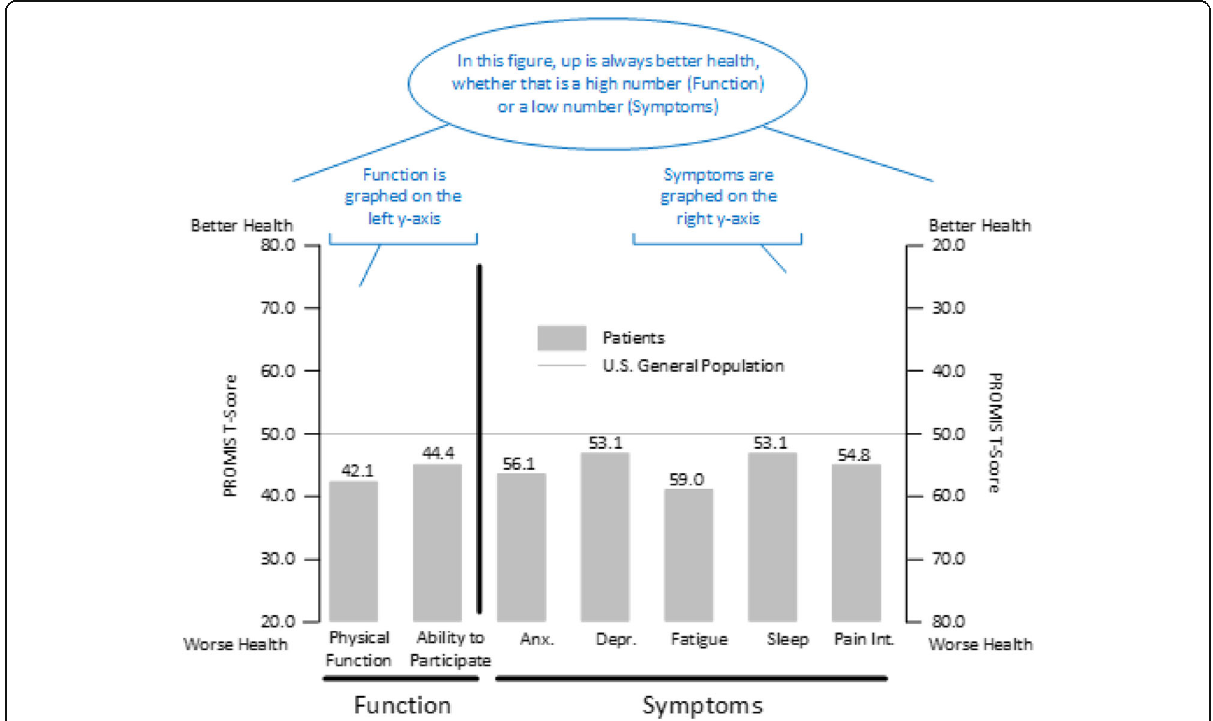
Fig. 1 Example results from the PROMIS-29 Profile v2.1. Notes are in